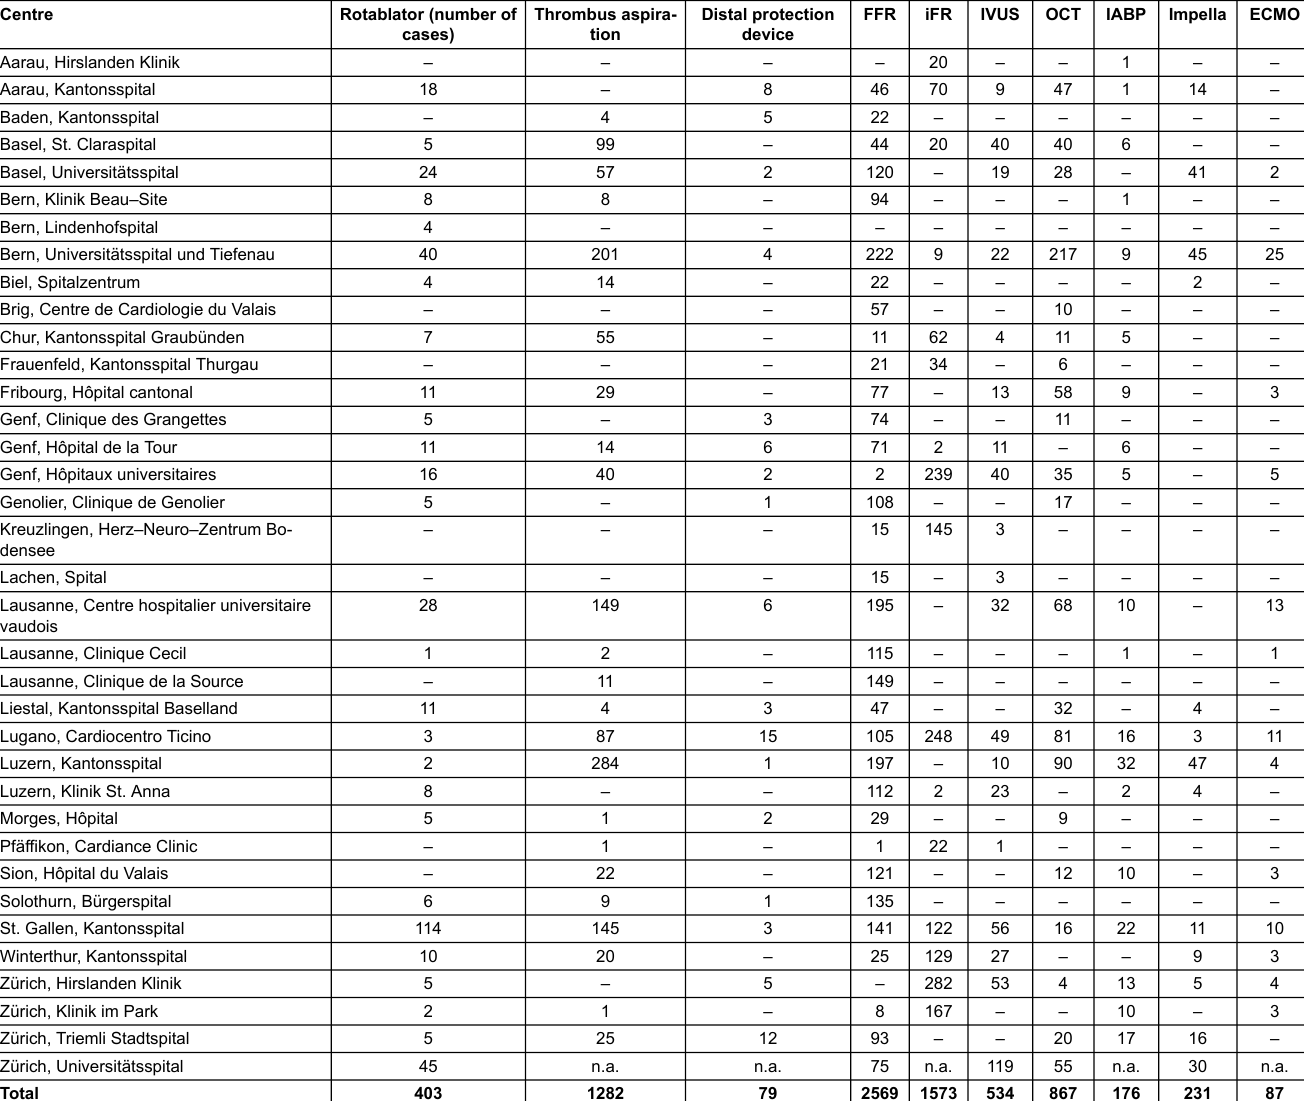
Table 4: Characteristics of the coronary interventions: revascularisation techniques (other than balloon angioplasty), pressure measurements and mechanical support systems. Centre Rotablator (number of Thrombus aspira- Distal protection FFR iFR IVUS OCT IABP Impella ECMO cases) tion device – – – – 20 – – 1 – – 18 – 8 46 70 9 47 1 – – 4 5 22 – – – – – – 5 99 – 44 20 40 40 6 – – 57 – 8 8 – 94 – – – 1 – – 4 – – – – – – – – – 40 201 Biel, Spitalzentrum 4 14 – 22 – – – – 2 – – – – 57 – – 10 – – – 7 55 – 11 62 4 11 5 – – Frauenfeld, Kantonsspital Thurgau – – – 21 34 – 6 – – – Fribourg, Hôpital cantonal 11 29 – 77 – 13 58 – 3 Genf, Clinique des Grangettes 5 – 3 74 – – 11 – – – Genf, Hôpital de la Tour 11 14 6 71 2 11 – 6 – – Genf, Hôpitaux universitaires 16 40 239 – Genolier, Clinique de Genolier 5 – – – – – – Kreuzlingen, Herz–Neuro–Zentrum Bo- – densee